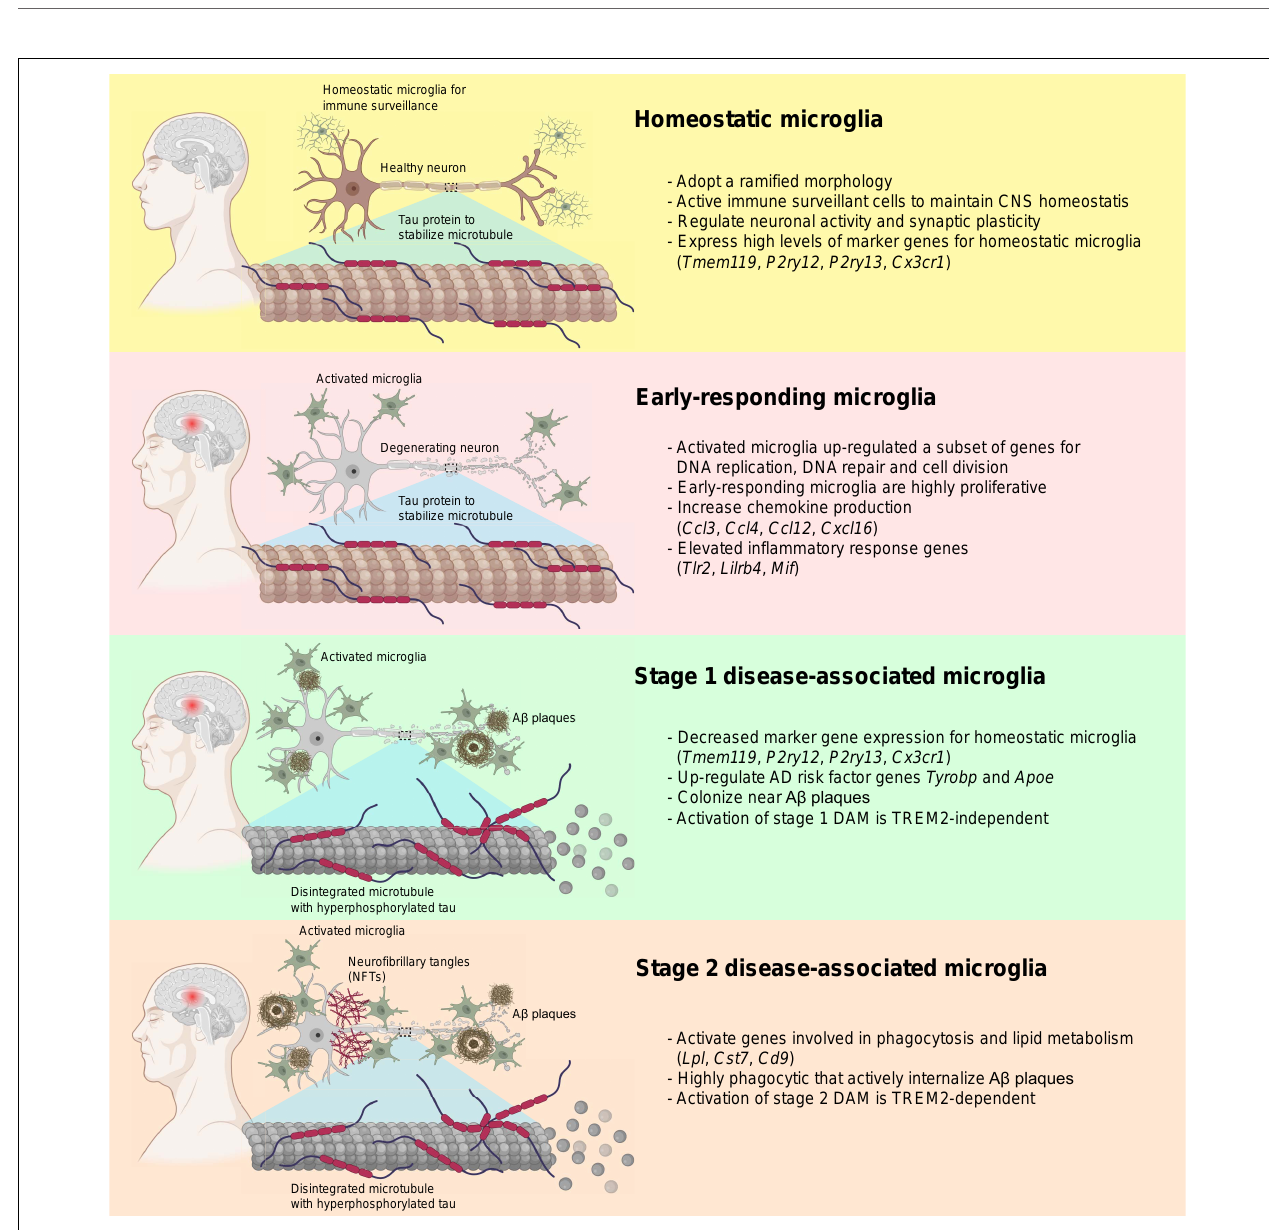
homeostatic microglia gene signature (i.e., P2ry12 , Gpr34 , Tmem119 , Tgfbr1 , and Csf1r ), while the genes essential for the DAM phenotypic transformation were suppressed ( Trem2 , Axl , Clec7a , Csf1 , Itgax , Cd34 , and Apoe ) (Krasemann et